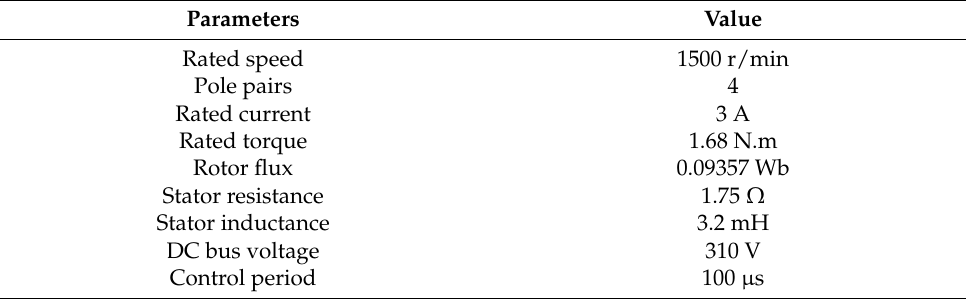
Table 1. Parameters of SPMSM control system.